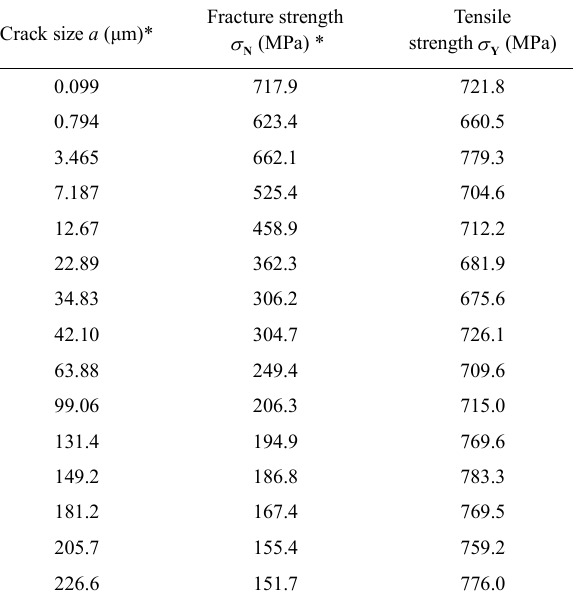
Table 1 Si 3 N 4 ceramic results digitized from Kimoto et al . [50] and our